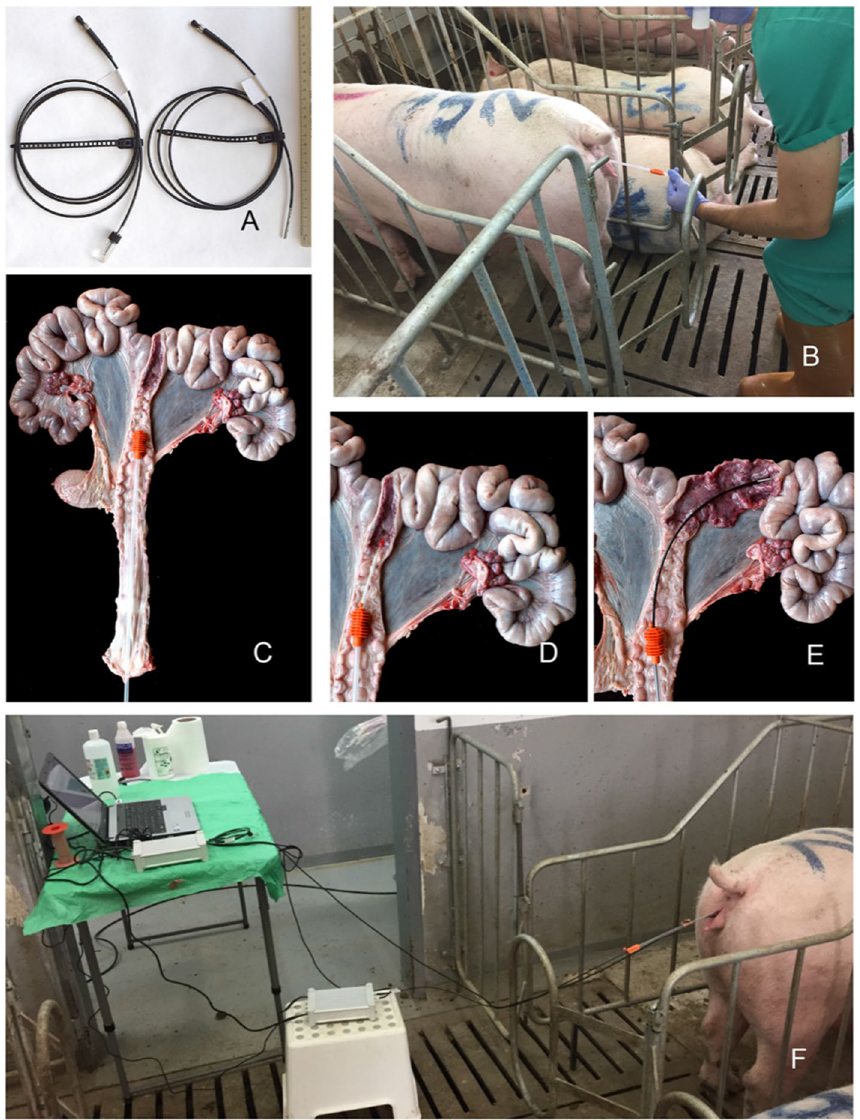
Figure 4. (A) Optical dipping probes of pH (right) and CO 2 (left). (B) Insertion of disposable post-cervical AI catheter. (C) Ex-vivo genital tract simulating the estimated location of the AI catheter in the cervix. (D) Detail of “C” showing how the inner cannula of the AI catheter reaches the body of the uterus. (E) Detail in ex-vivo reproductive tract simulating how the pH probe is inserted within the uterus. After having passed through the AI catheter, the probe was pushed up to reaching the body and horns of the uterus. (F) Data recording from the uterus once the stabilization period is